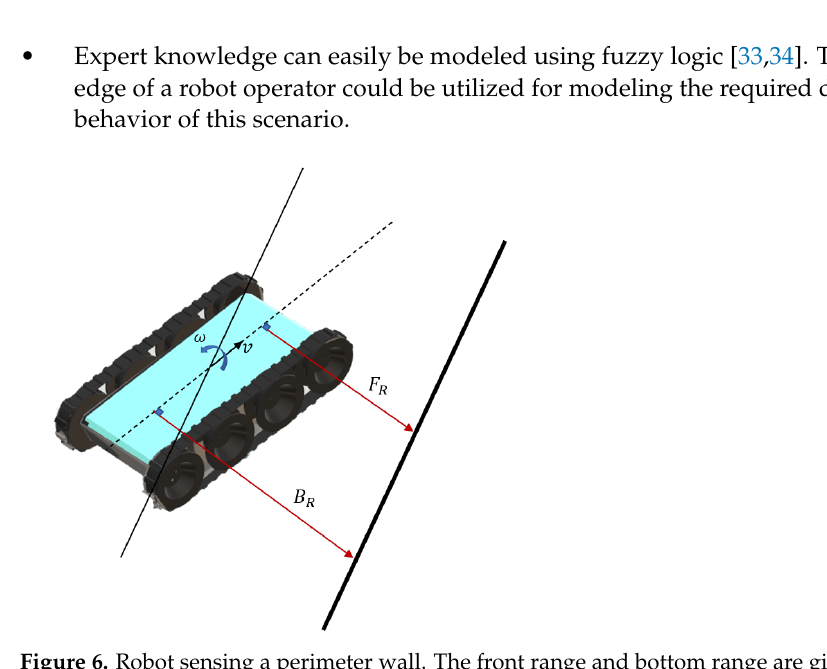
Figure 6. Robot sensing a perimeter wall. The front range and bottom range are given as F R and B R , respectively. The angular velocity and linear velocities are given as w and v ,